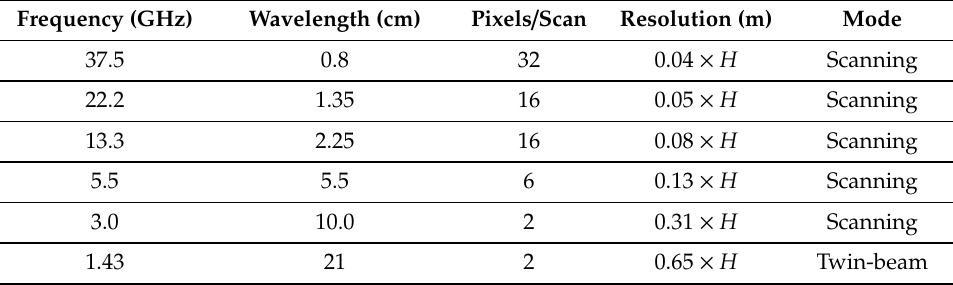
Table 1. Characteristics of the remote sensing sensors which are equipped by the IL-18 platform [26,27].